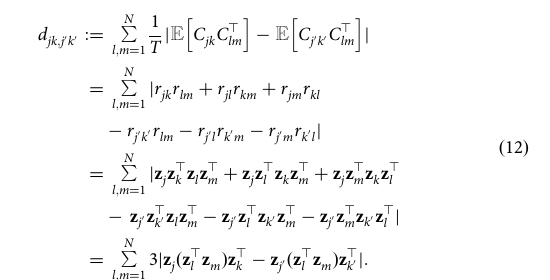
ffiffiffiffiffiffiffiffiffiffiffiffiffiffiffiffiffiffi ∑ t c lm